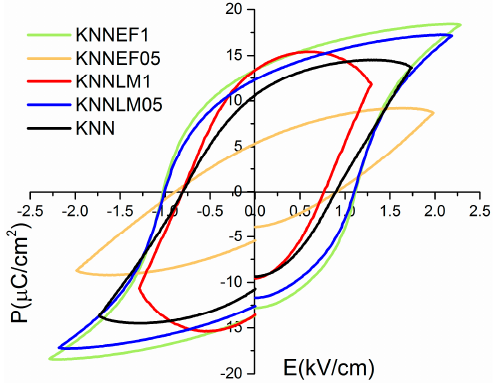
Figure 8. Ferroelectric loops of KNN and its solid solutions.